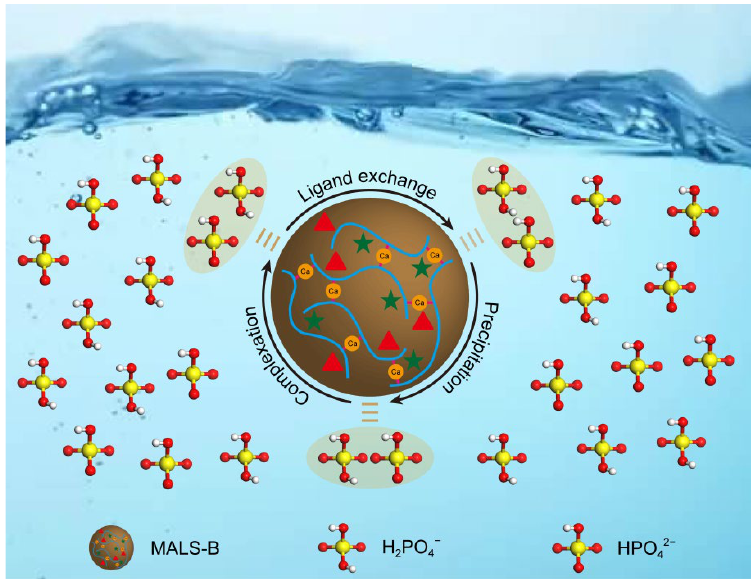
Figure 11. Proposed adsorption mechanisms for phosphate removal by